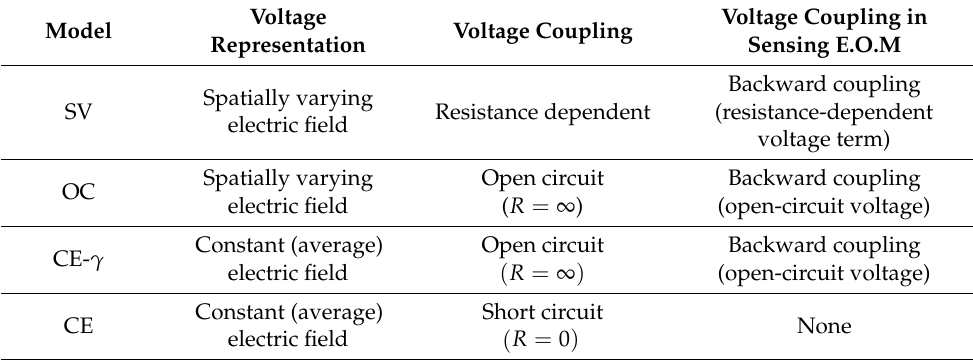
Voltage Coupling Resistance dependent